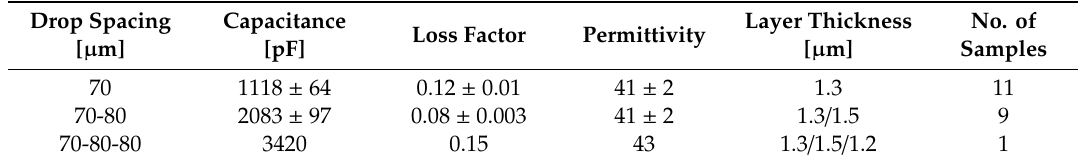
Table 2. Capacitances, loss factors, permittivities and layer thicknesses of the multilayer capacitors with a drop spacing of 70-80-80 µ m. The measurements were carried out at 200 kHz and are averaged over 5 individual values for every single sample.